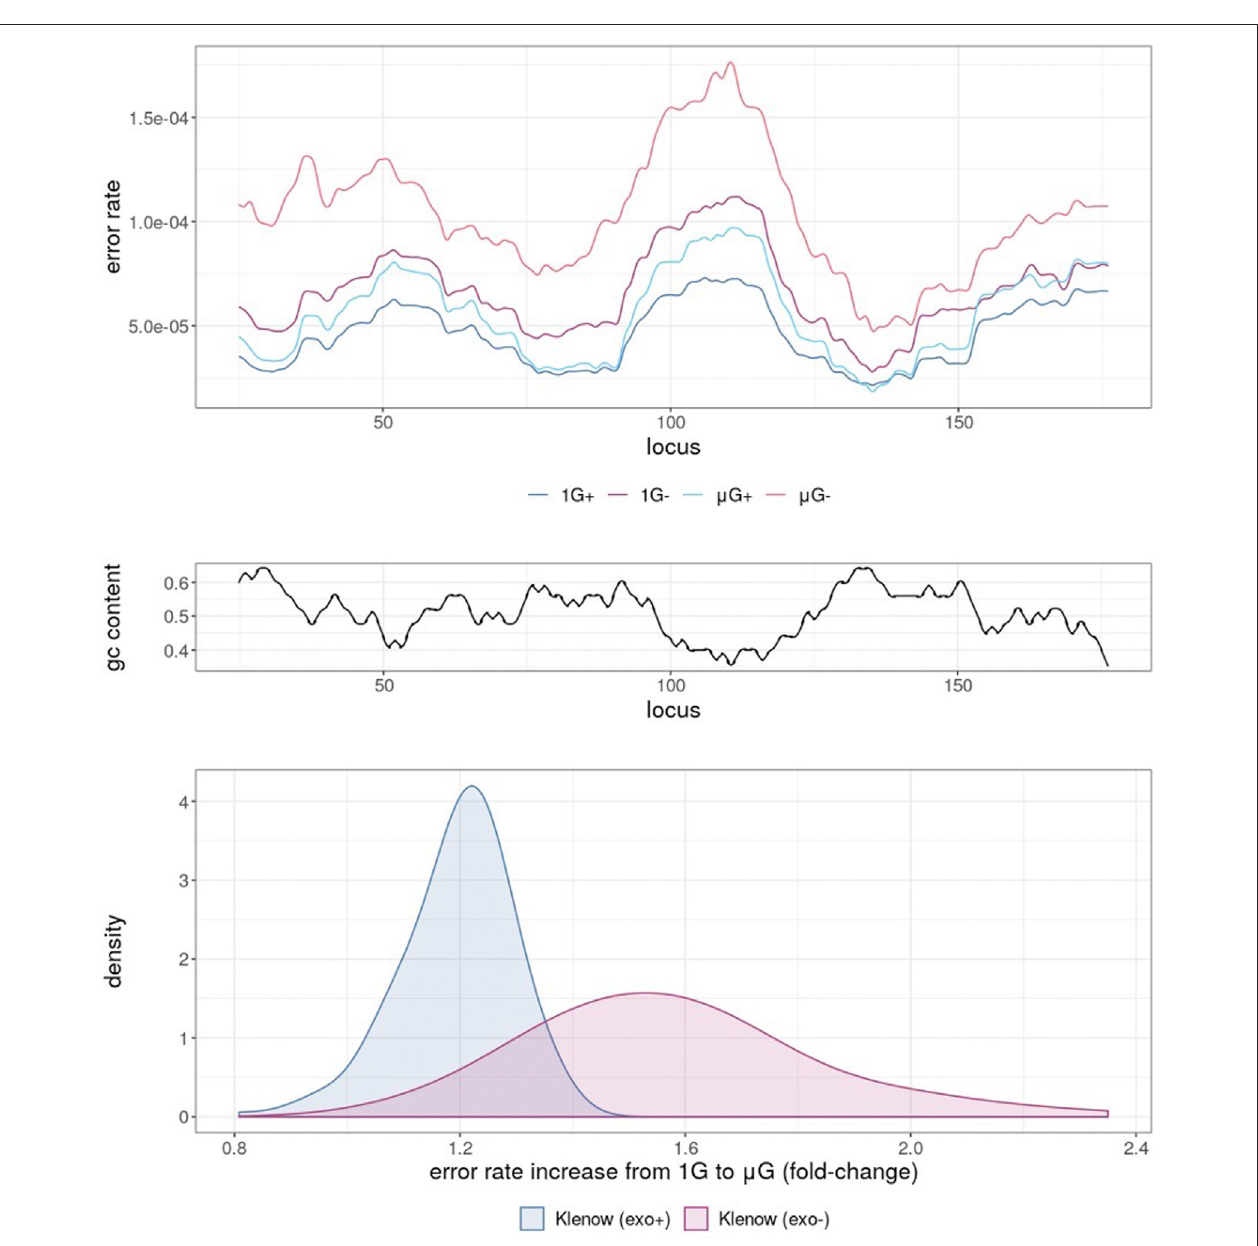
FIGURE 3 | Simple moving average of polymerase error rate across 25 nt windows of template under different experimental conditions, either earth-like gravity (1G) or microgravity ( μ G) with + and – referring to the presence or absence of exonuclease activity in the Klenow fragment polymerase. (A) The mean error rates of each test sample for each 25 nt window moving across the template, such that at locus (cid:1) 25, error rate was the mean of loci 1 – 25, with the experimental conditions shown as colored lines corresponding to 1 G+ (blue), 1 G − (mauve), µG+ (turquoise) and µG- (orange). (B) G + C% (gc content) in 25 nt windows sliding across the template sequence. (C) Density plot of mean error-rate increases in microgravity for Klenow (exo+) and Klenow (exo-) for each 25 nt window along the template.